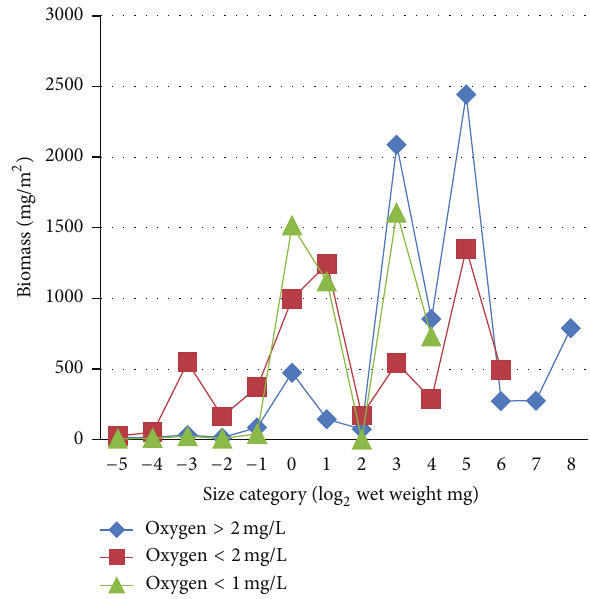
Figure 4: Polychaete biomass size structure (BSS) under different oxygen concentrations, as indicated. The 𝑦 -axis is total wet weight biomass under each line; the 𝑥 -axis is the size categories, as